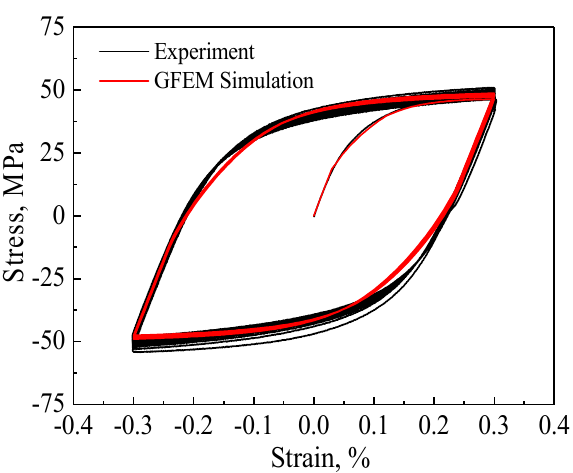
Figure 7. The comparison of the cyclic stress–strain curves under tension-compression loading by test and crystal plasticity simulation with the GFEM containing 3600 grains. Table 2. The material parameters of single crystal aluminum.